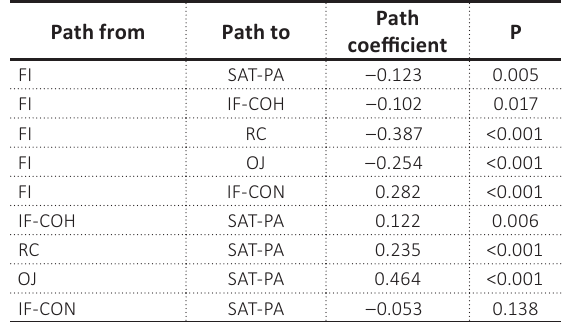
Table 4. Model estimates